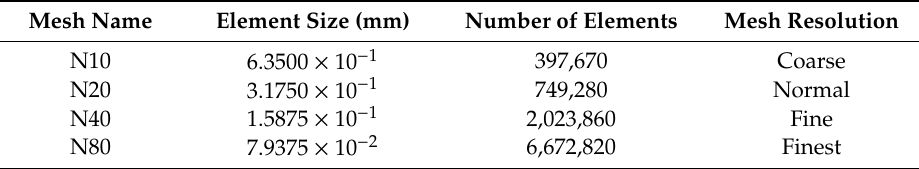
Table 2. Computational mesh parameters.